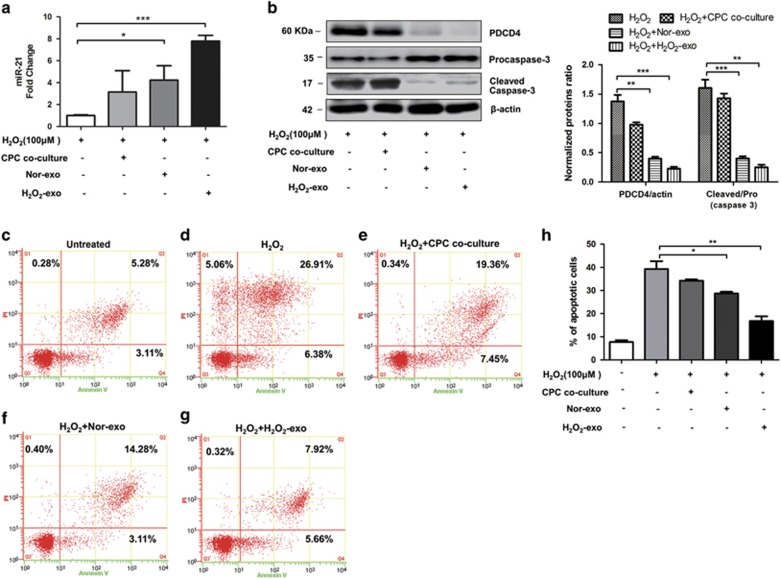
CPC-exosomes inhibit the apoptotic function caused by H2O2 in cardiomyocytes. (a) RT-qPCR analyzed miR-21 in H9C2 cells under 100 μM H2O2 after CPCs co-culture, Nor-exo and H2O2-exo pre-protection (N=4, *P<0.05, ***P<0.001 versus control group). (b) Western blotting analyzed procaspase-3, cleaved caspase-3 and PDCD4 in H9C2 cells under 100 μM H2O2 after CPCs co-culture, Nor-exo and H2O2-exo pre-protection (N=4, **P<0.01, ***P<0.001 versus control groups). (c–g) Representative dot plots of cell apoptosis were showed after Annexin V/PI dual staining. (h) The percentage of apoptotic cells was represent for both early and late apoptotic cells (N=3, *P<0.05, **P<0.01 versus H2O2 groups)